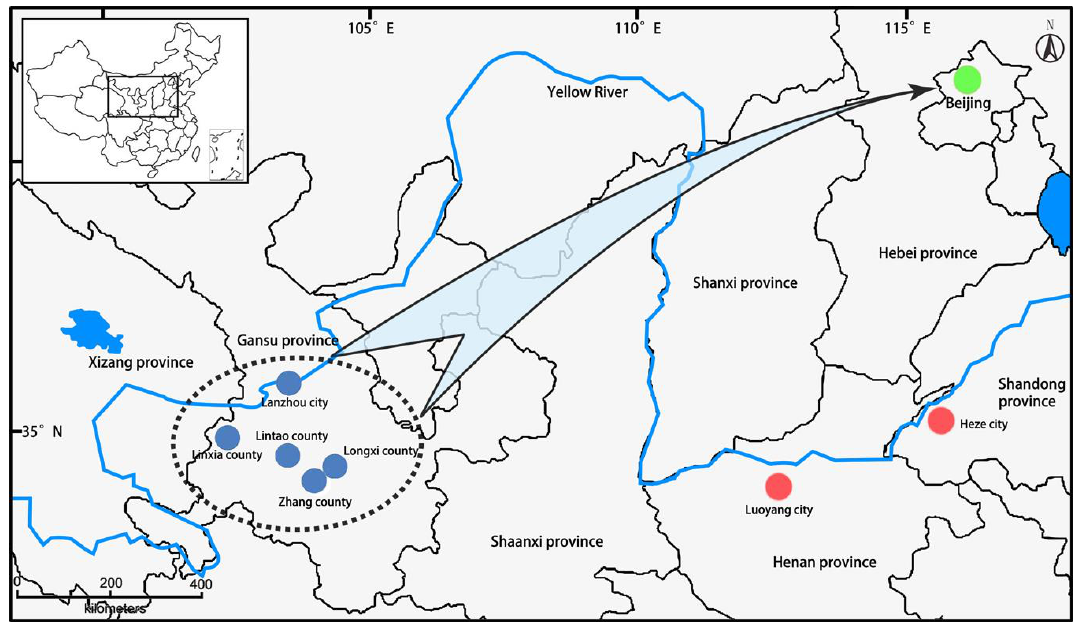
Figure 2. Geographic origins of the flare tree peony (FTP) accessions used in this study. These accessions were selectively collected in the cultivation center (dotted area) of FTP in the middle of Gansu province where the blue dots represent the concrete places, and then propagated clonally and transplanted into the conservation site of Beijing (the green dot). The red dots represent Luoyang and Heze, the two traditional cultivation centers of common tree peony (CTP) in China.